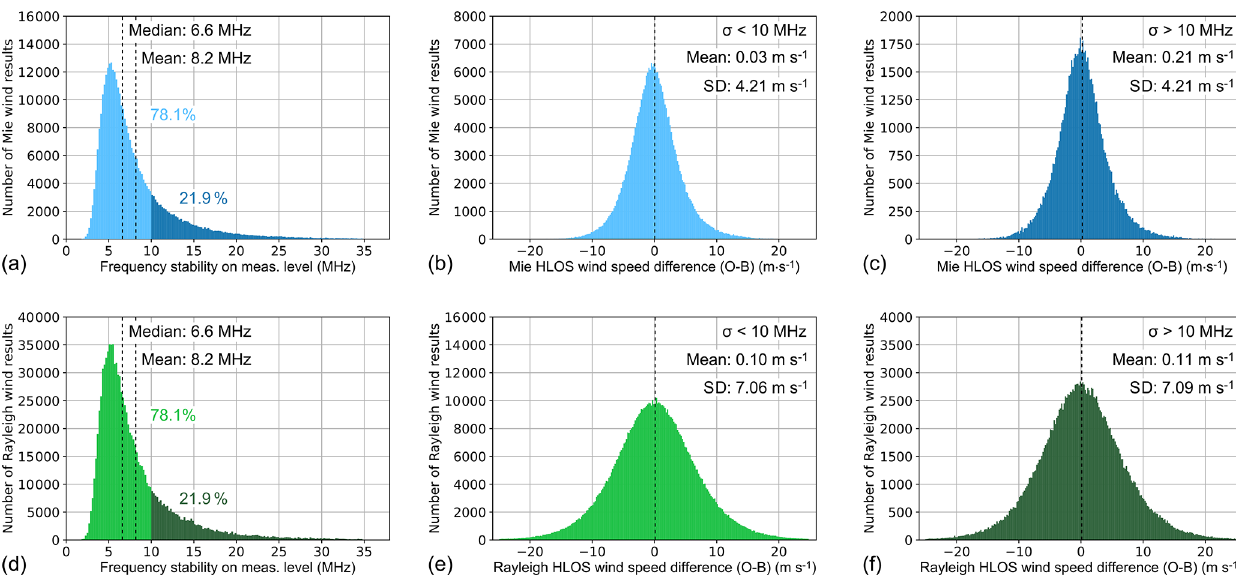
Figure 12. (a) Histogram of the laser frequency stability on the measurement level for those measurements that yielded valid Mie winds during the period from 17 to 24 August 2020 (bin size: 0.2MHz). The probability density functions of the wind speed difference with respect to the ECMWF model background (O–B) are shown in panels (b) and (c) for measurements with a frequency stability better and worse than 10MHz, respectively (bin size: 0.2ms − 1 ). The bottom panels depict the corresponding statistics for the Rayleigh wind